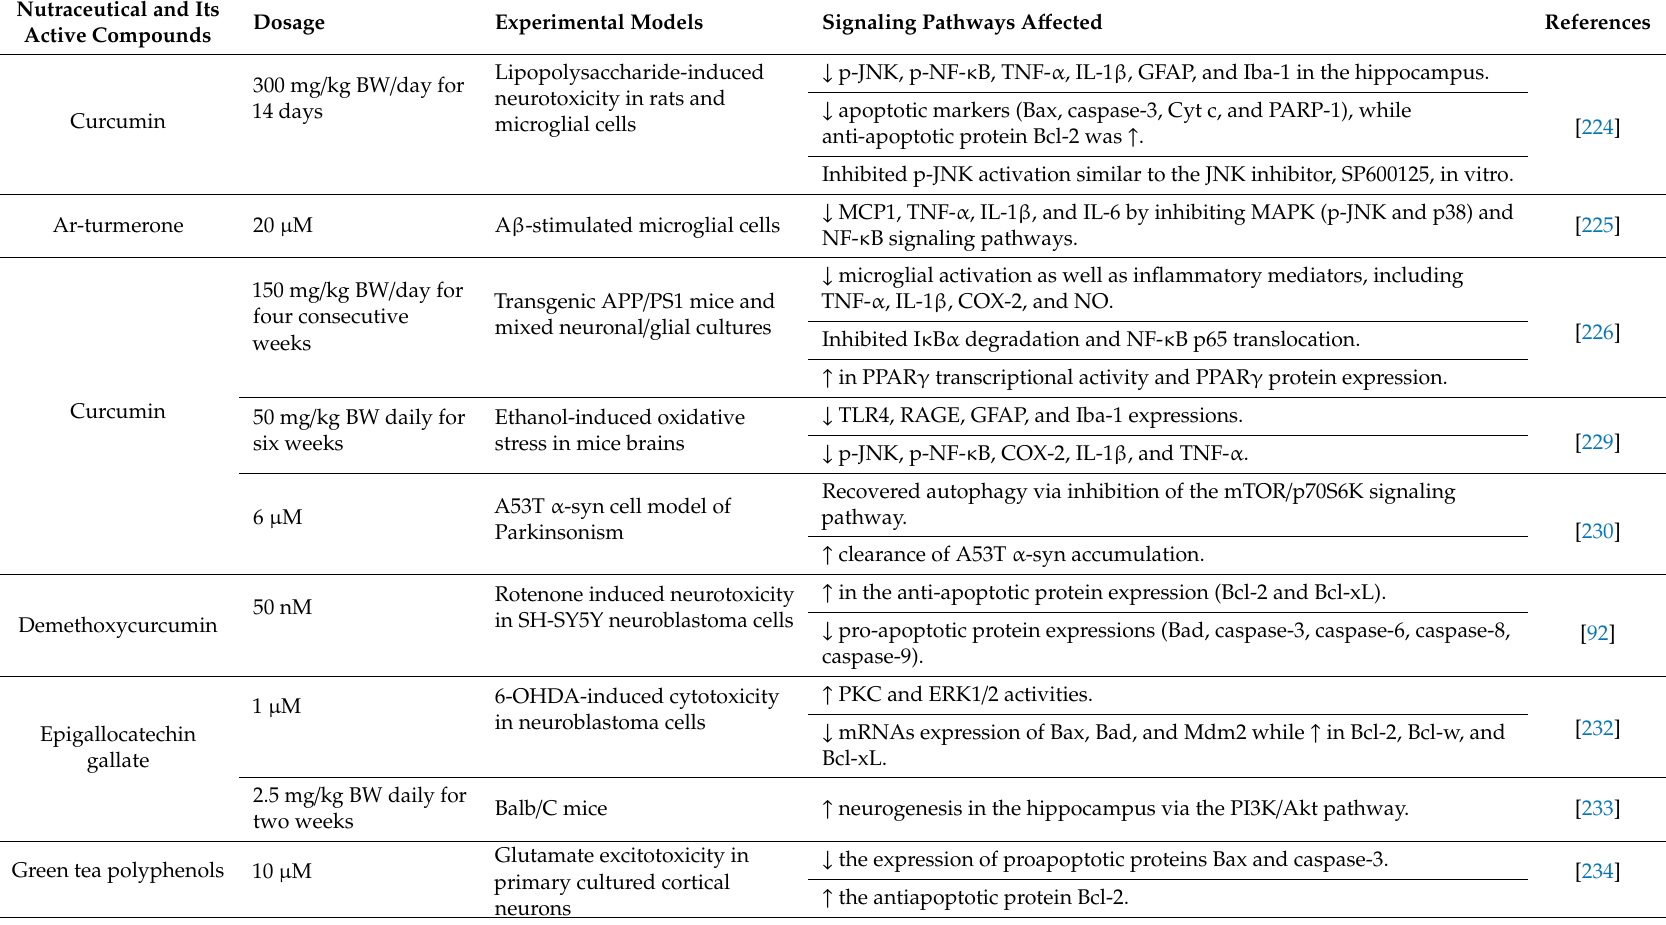
Table 4. Regulation of apoptosis, inflammation, and survival signaling pathways by